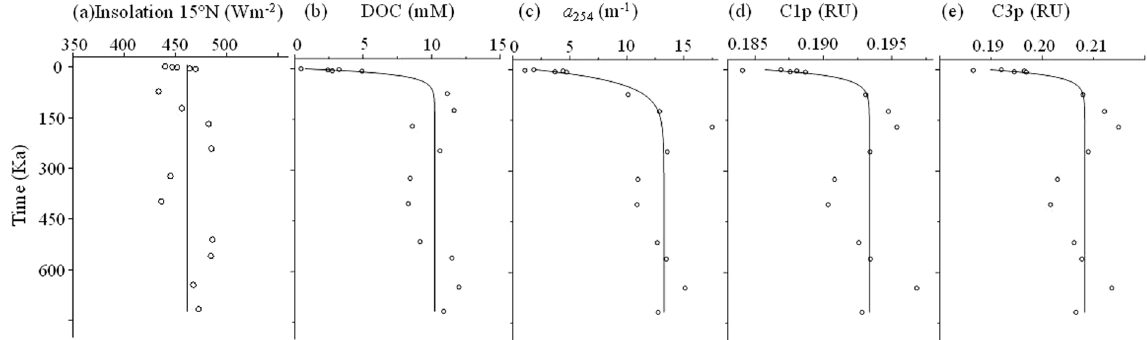
Figure 4. Examples of exponential production (R 2 ≥ 0. 98, p < 0.0001) of DOC, CDOM, and FDOM with time above the SMTZ followed by insolation-paced oscillations (linear correlation R 2 ≥ 0. 4, p < 0.05) in the downcore profiles of pore waters at site U1.